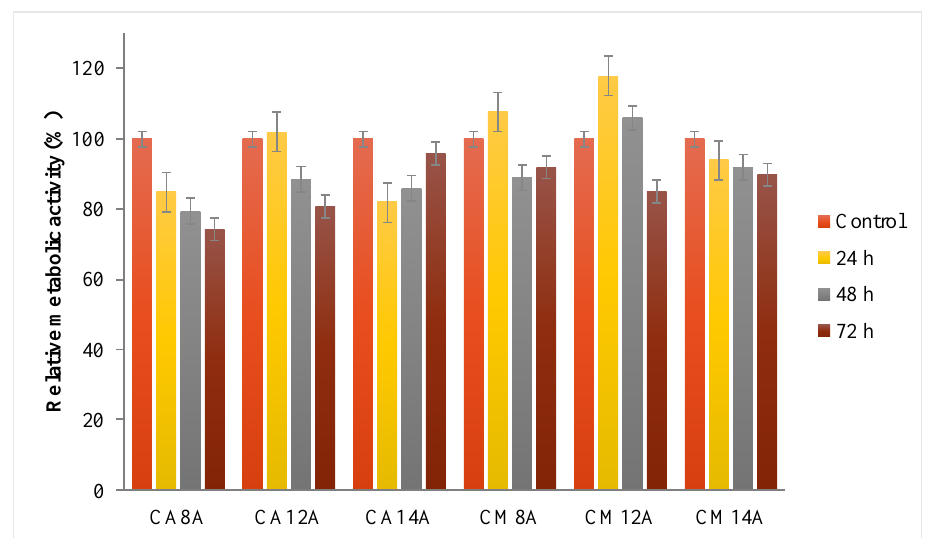
Figure 8. Relative metabolic activity data from the MTT assays for hydrogels with AA or AM, obtained with 0.8%, 1.2% and 1.4% APS, respectively, tested for different time intervals.